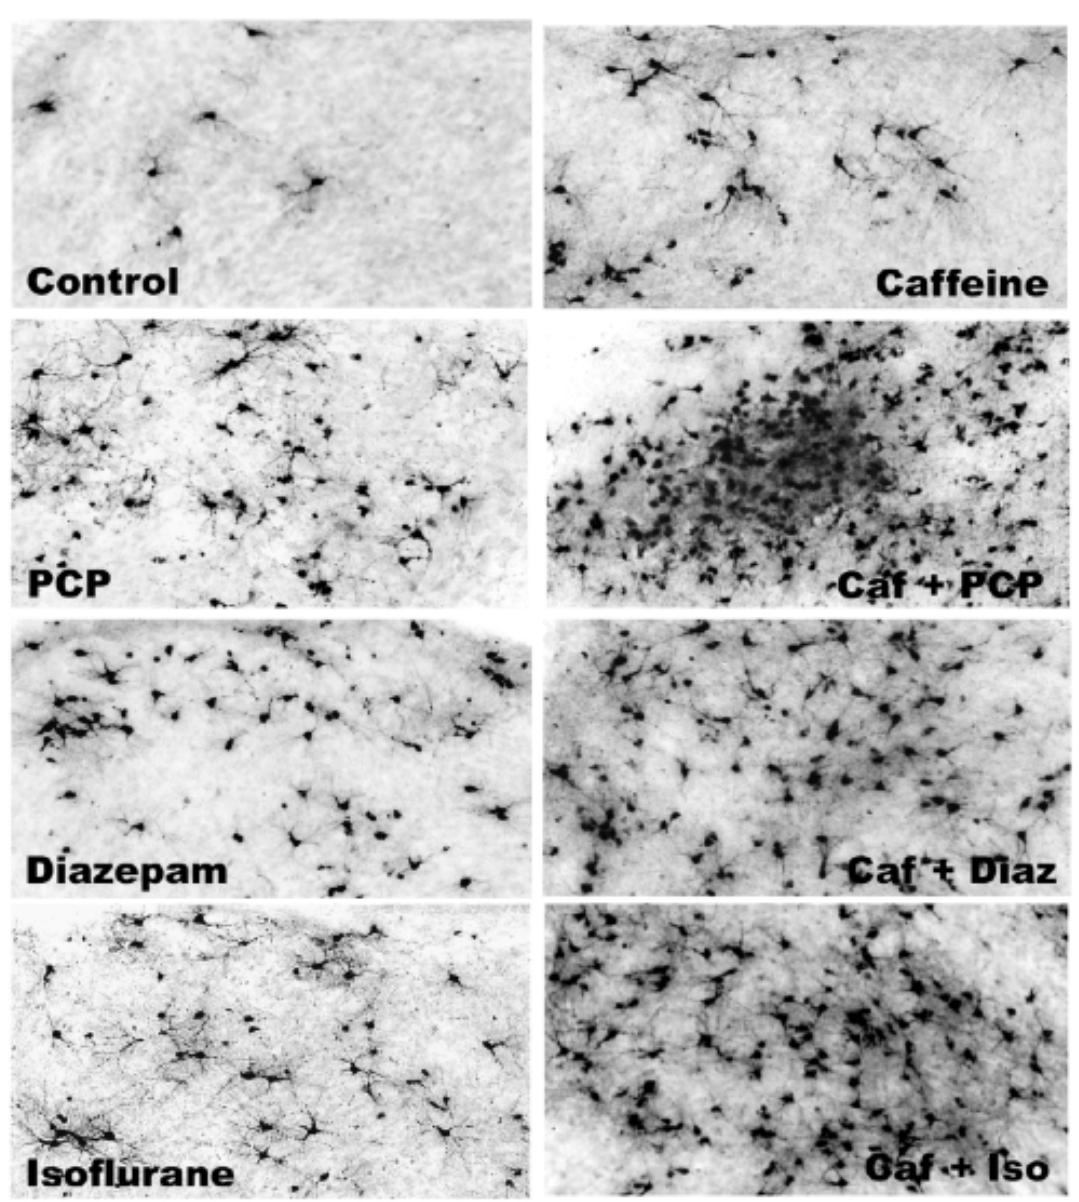
Figure 7. Neuroapoptosis in the Thalamus. These detail views focus on the dorsomedial thalamic nucleus and neighboring thalamic nuclei. Compared to the control brain, there is a substantially higher density of apoptotic profiles in the brains exposed to caffeine, PCP, diazepam or isoflurane, and show a low density of apoptotic profiles in the control brain and a more striking increase in the brains exposed to caffeine in combination with PCP, diazepam or